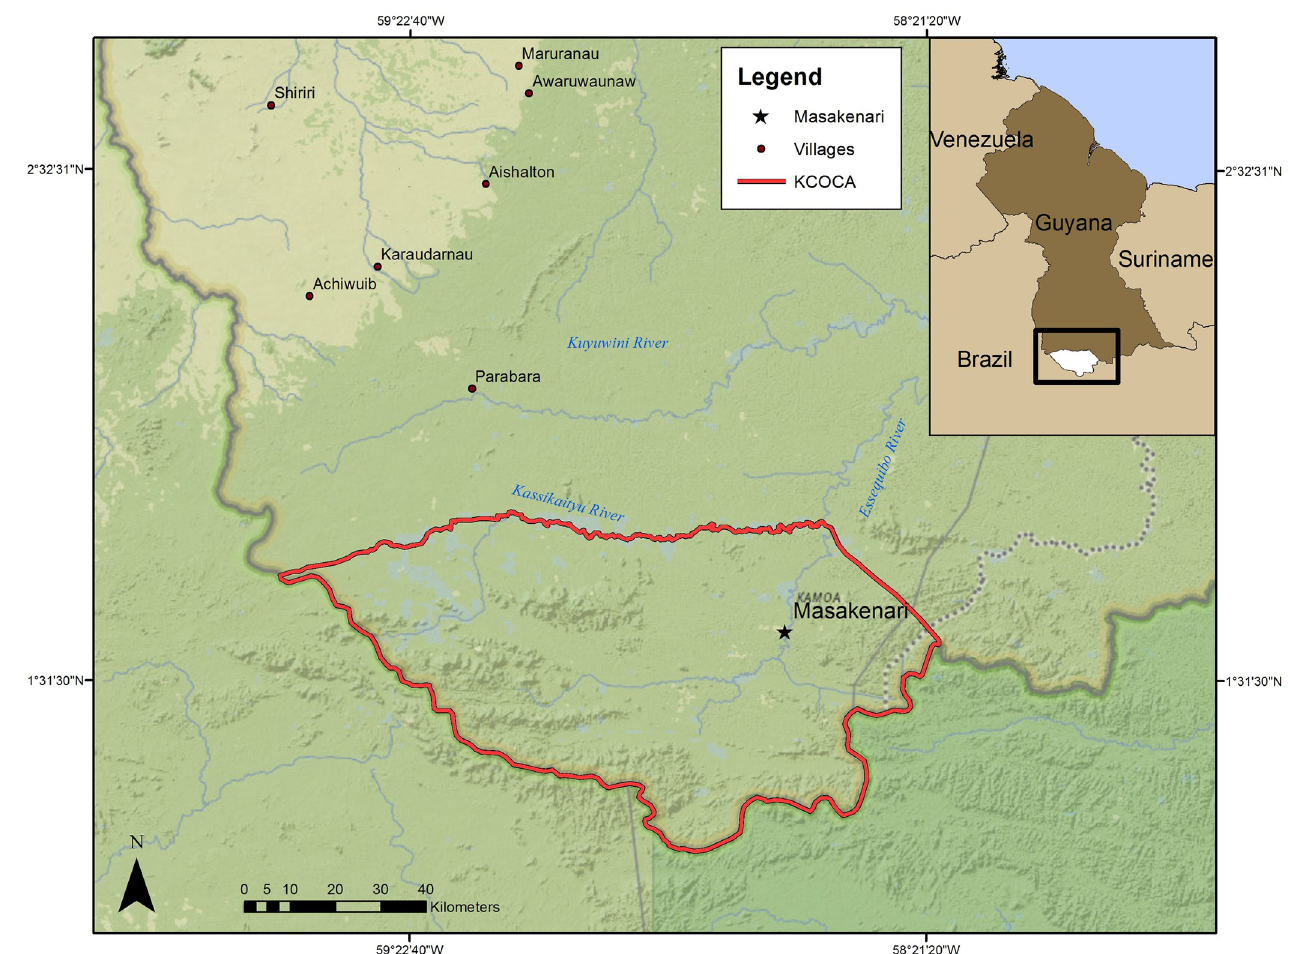
Fig 1. Map of the the Konashen Community Owned Conservation Area (KCOCA) and the nearest villages. Service Layer Credits: Sources: National Geographic, Esri, DeLorme, HERE, UNEP-WCMC, USGS, NASA, ESA, METI, NRCAN, GEBCO, NOAA, iPC.